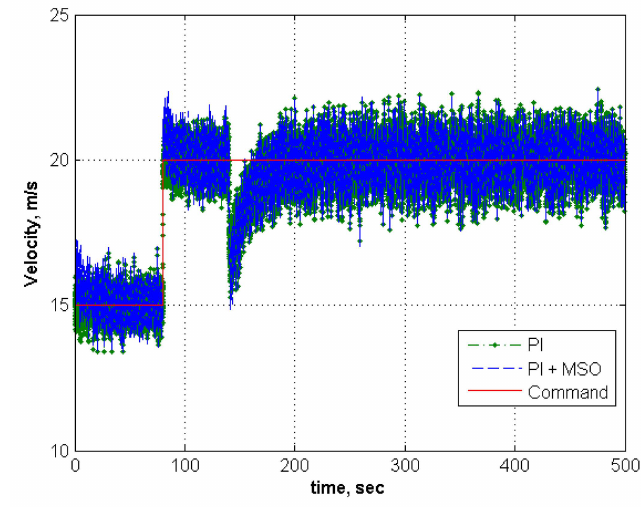
Figure 8. Load factor for 100% C m α .